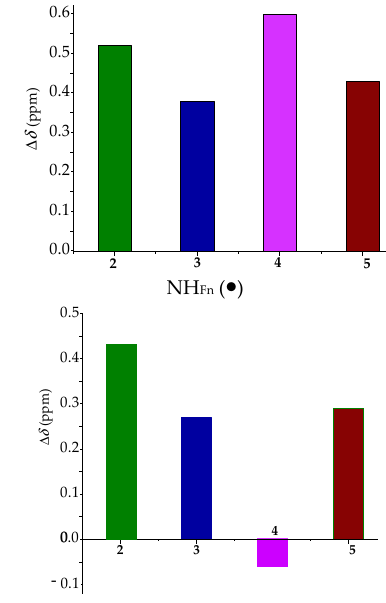
Figure 8. Changes in chemical shifts ( ∆ δ ) of NH Fn ( • ) and NH Ala ( (cid:78) ) in peptides 2 – 5 in CDCl 3 from 258–328 K ( c = 1 × 10 − 3 M in CDCl 3